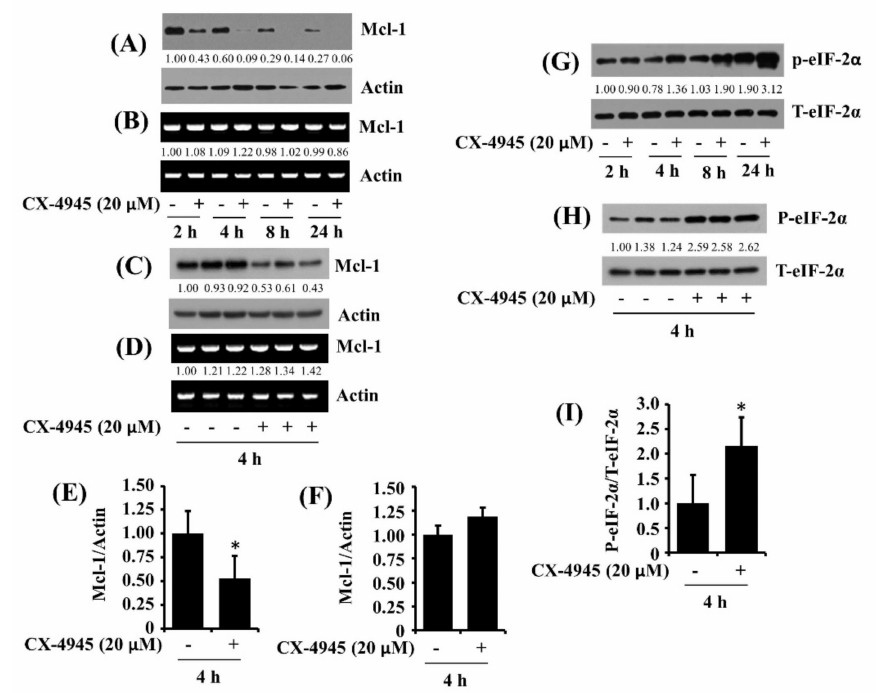
Figure 6. Effects of CX-4945 on expression and phosphorylation of Mcl-1, eIF-2 α in HuCCT-1